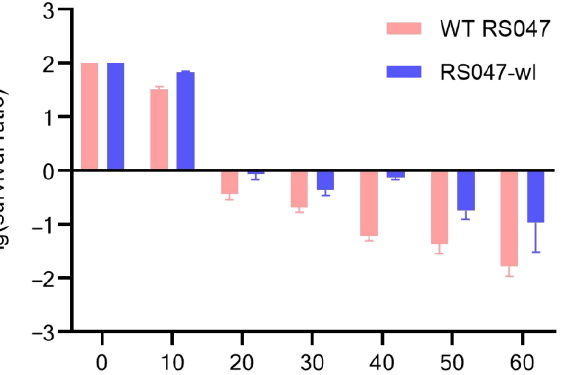
Figure 2. Procedures for adaptive laboratory evolution experiment. The duration of the heat shock was 30 min, and after the heat shock, cells were cooled down on ice for 5 min, followed by incubation of 24 h at 37 °C.